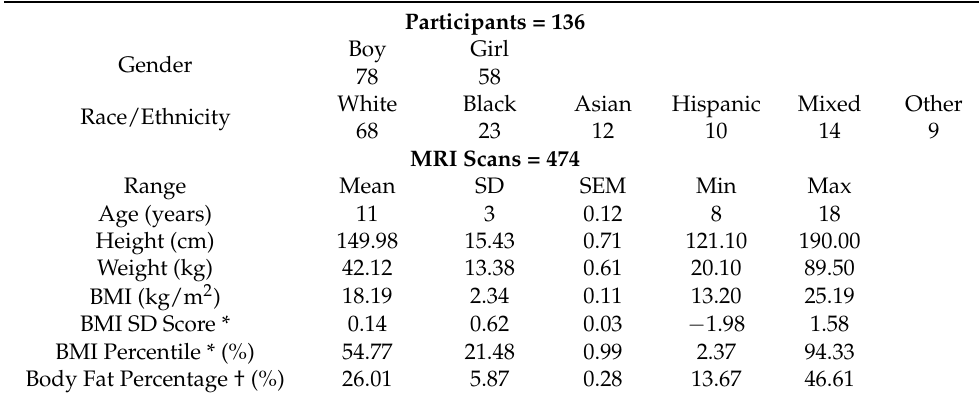
Table 1. Demographic information for the study participants undergoing abdominal MRI for fat quantification (SD: standard deviation, SEM: standard error of the mean, BMI: body mass index). Participants = 136